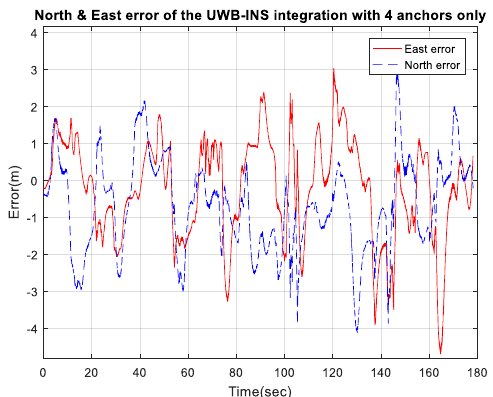
Figure 14. RMSE Errors trend in North and East directions for the UWB system with lower infrastructure utilized (configuration f )